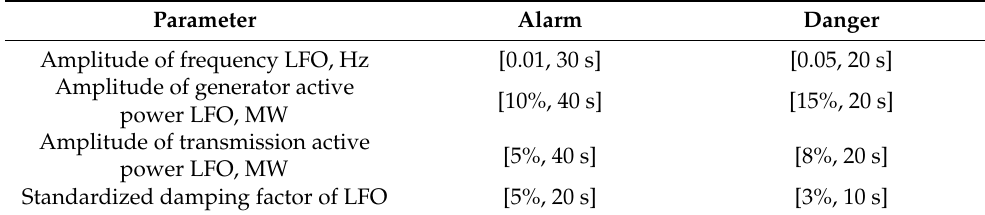
Table 2. Values of LFO threat